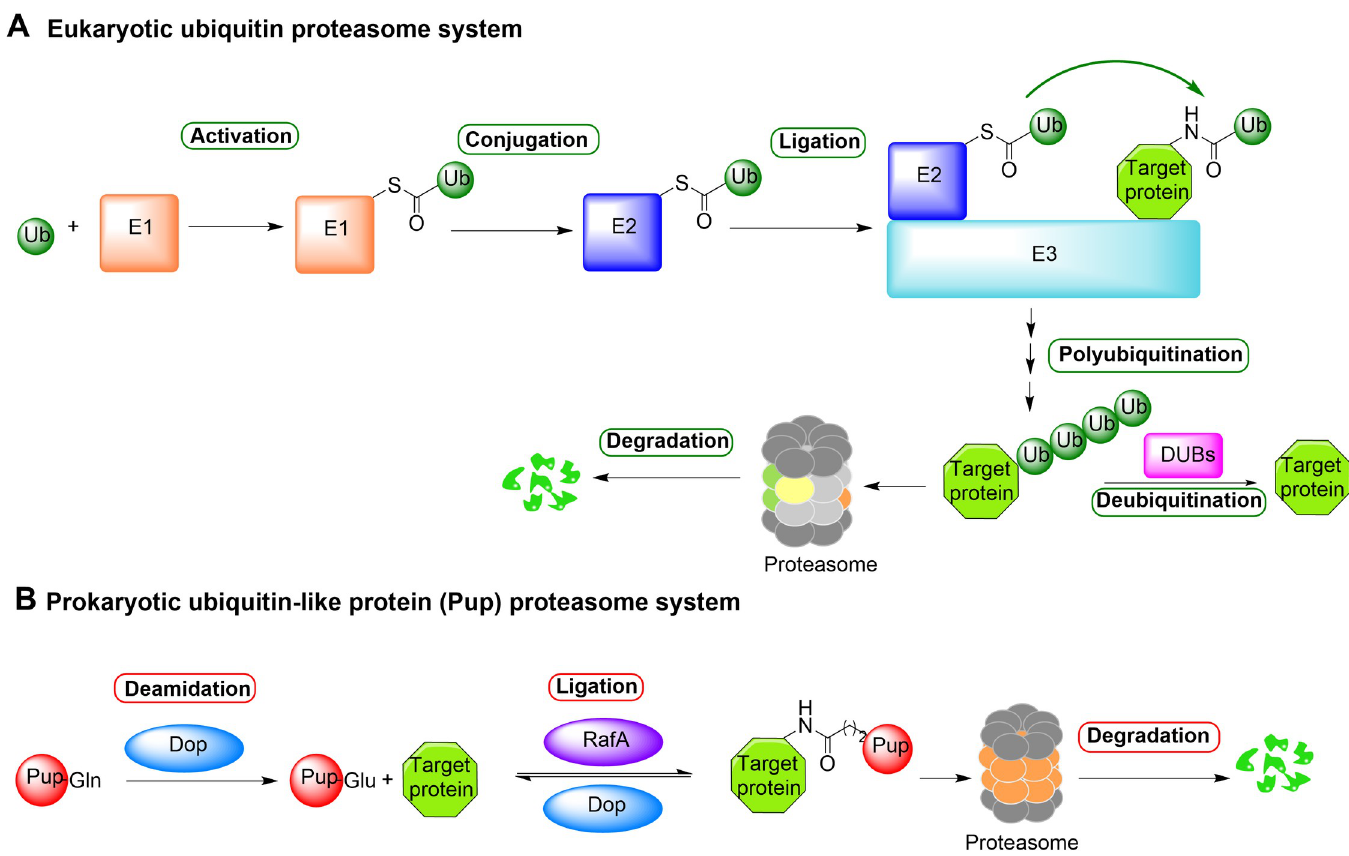
Fig 1. Ubiquitin-proteasome system in eukaryotes and Pup-proteasome system in Mycobacterium . DUB AU : AnabbreviationlisthasbeencompiledforthoseusedinFig 1 : Pleaseverifythatallentriesarecorrect : , deubiquitinase; Pup, prokaryotic ubiquitin-like protein.